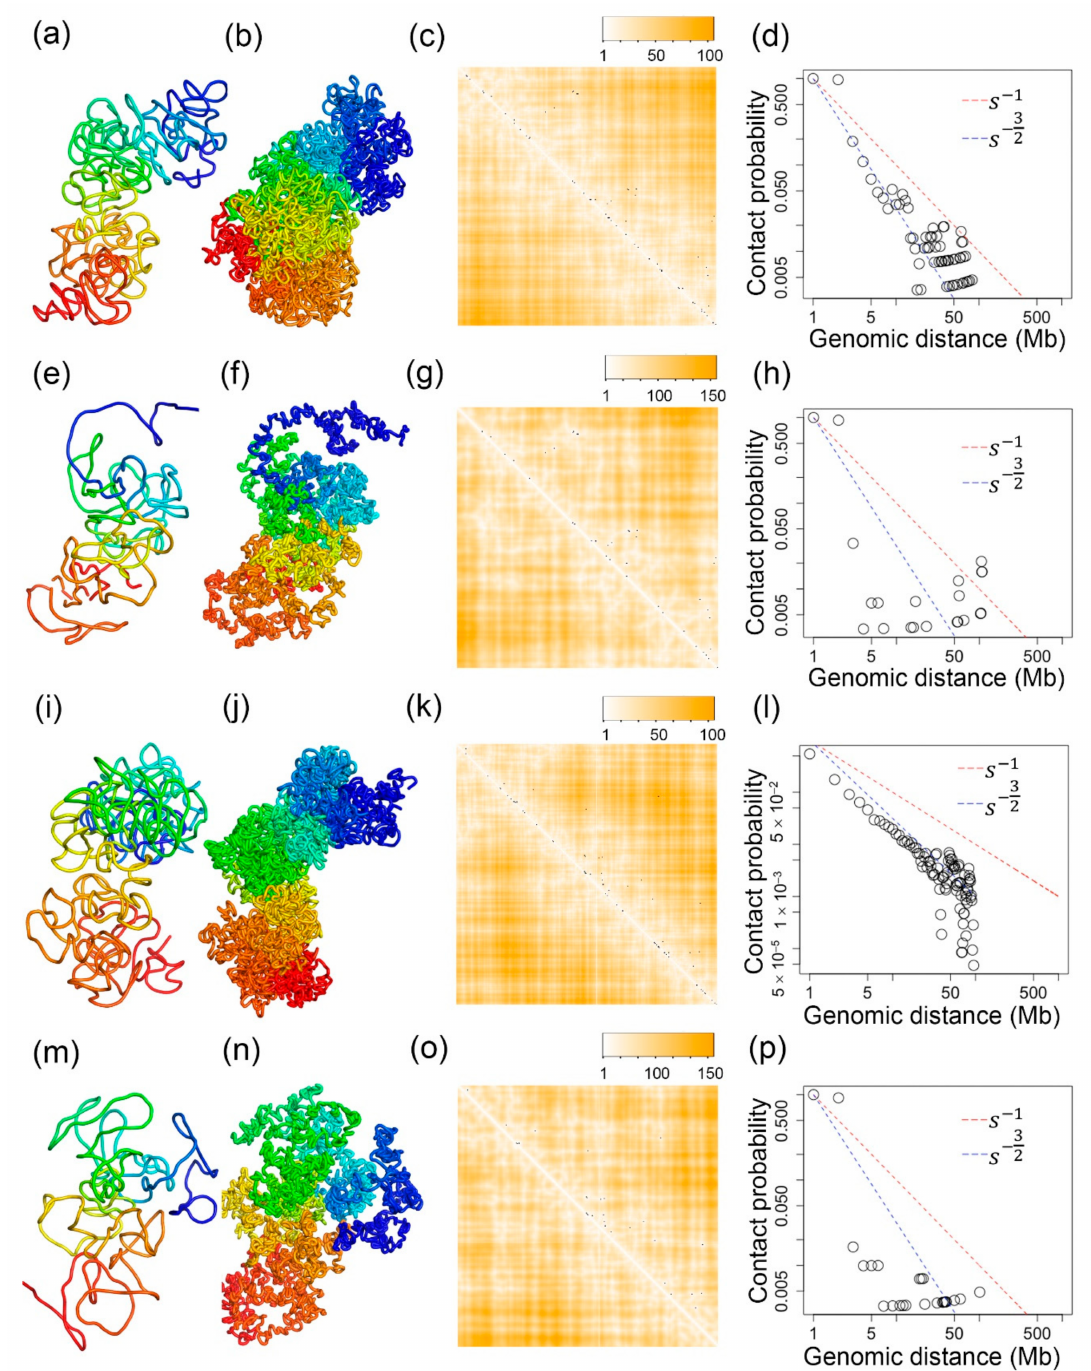
Figure 5. ( a , i ) The 500 kb resolution 3D structures of the inactive and active X-chromosome of a GM12878 cell, which is inferred by our Lennard-Jones method, respectively. ( e , m ) The 500 kb resolution 3D structures of the inactive and active X-chromosome of a GM12878 cell, which is inferred by SCL, respectively. ( b , f , j , n ) are the 50 kb resolution structures corresponding to ( a , e , i , m ). ( c , d ) are the evaluations for ( a ). ( g , h ) are the evaluations for ( e ). ( k , l ) are the evaluations for ( i ). ( o ) and ( p ) are the evaluations for ( m